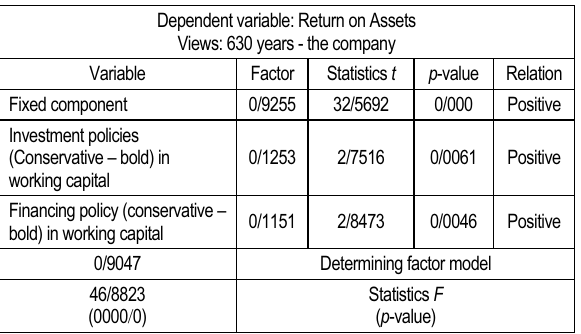
Table 5. 1-1 subhypotheses research results using fixed